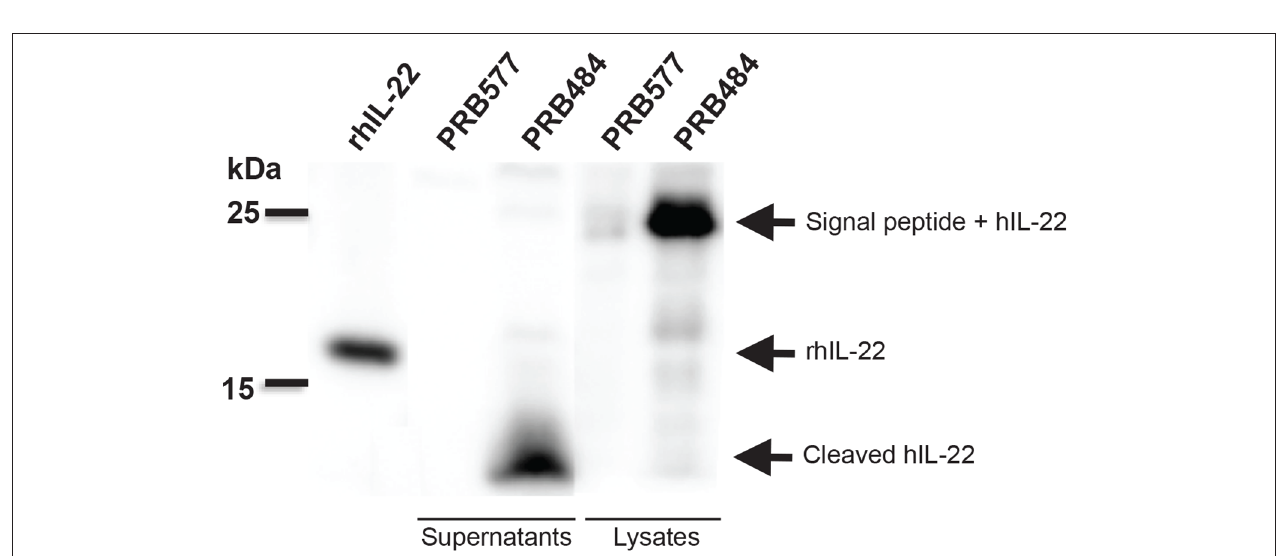
FIGURE 2 | Bacterially secreted hIL-22 is cleaved. Western blot of induced bacterial supernatant and cell lysates. Cell lysates of PRB484 show a band at ∼ 23 kDa, the expected size for hIL-22 fused to the signal peptide. In comparison, supernatants from induced PRB484 cultures show protein bands much smaller in size, ∼ 4 kDa representing cleaved